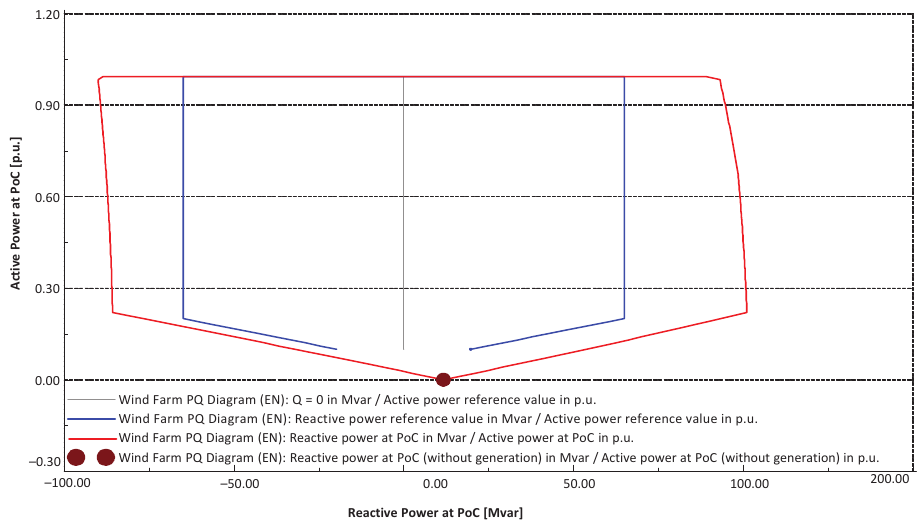
Figure 8. Modified reactive power capability of wind park after PPC set